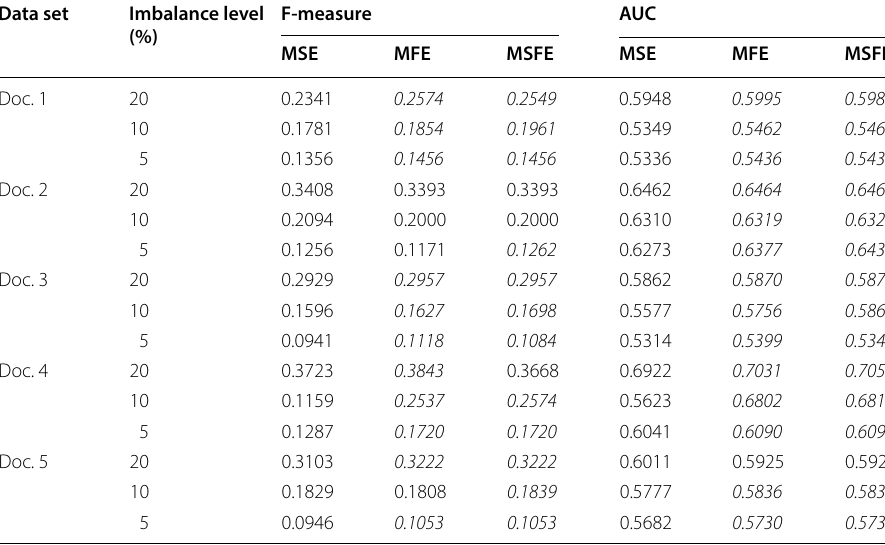
Italic scores indicate MFE/MSFE loss outperforming MSE loss